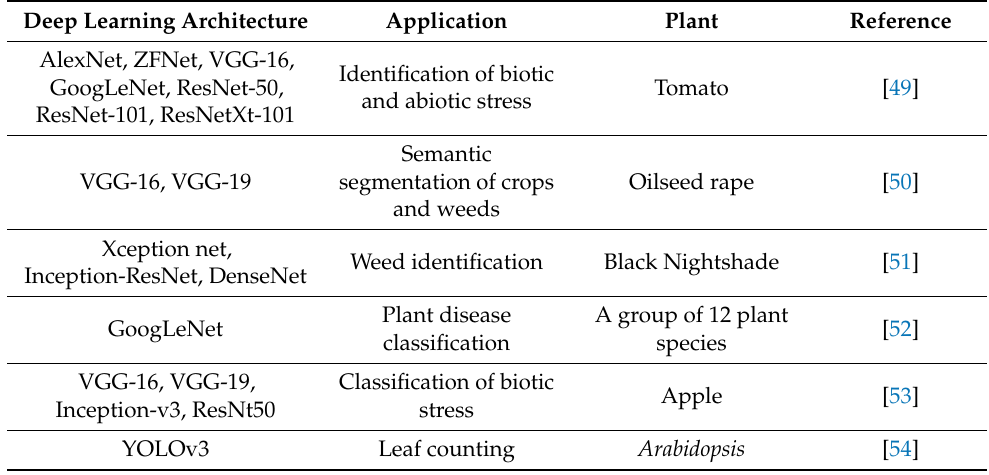
Table 2. Examples of deep learning architectures applied in plant phenotyping using transfer learning. Deep Learning